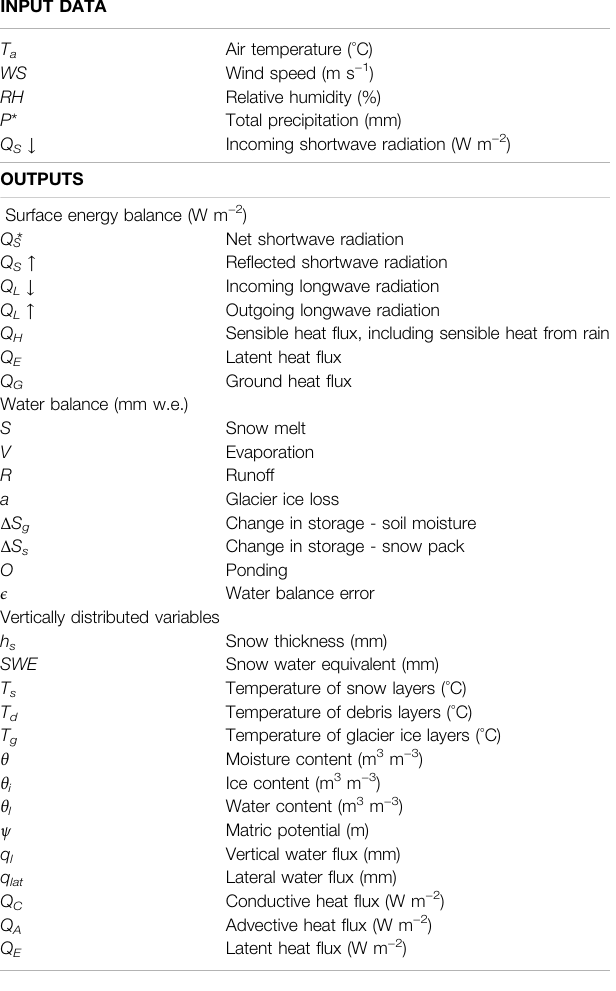
TABLE 2 | SHAW-Glacier input data requirements and outputs. Optional outputs relating to vegetation and solute transport are not listed. INPUT